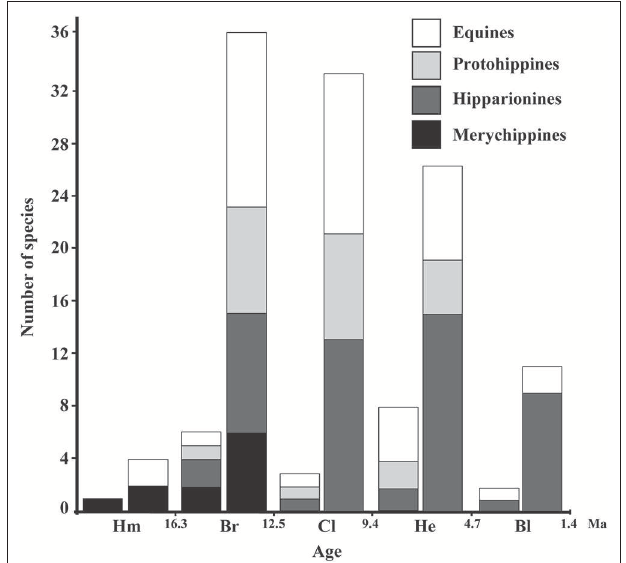
FIGURE 3 | Pattern of species richness of Neogene Equinae from Mexico (left column) and North America (right column). Hm, Hemingfordian; Br, Barstovian; Cl, Clarendonian; He, Hemphillian; Bl,